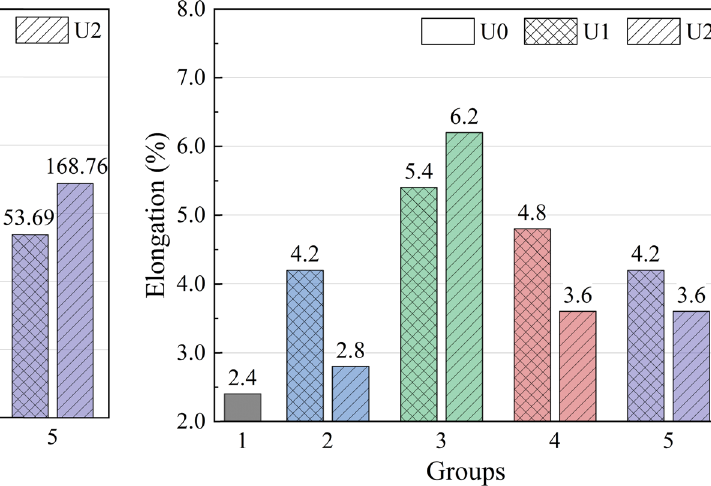
Figure 8: Comparison of the elongations of the casting samples in di ff erent